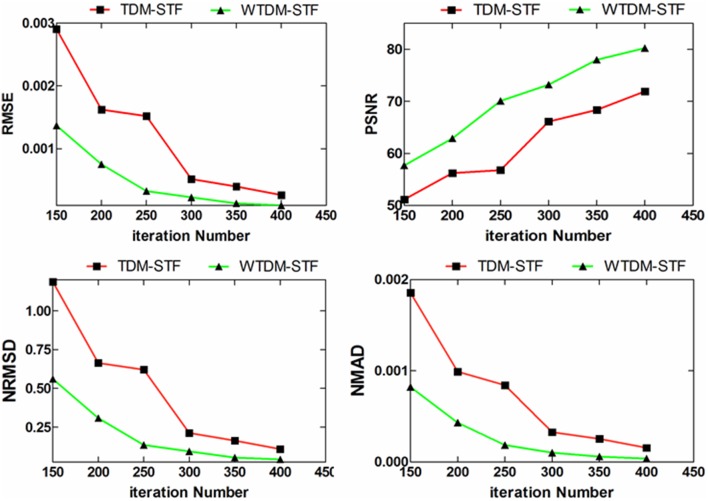
Different performance evaluations as a function of iteration numbers on the reconstructions by TDM-STF and WTDM-STF.